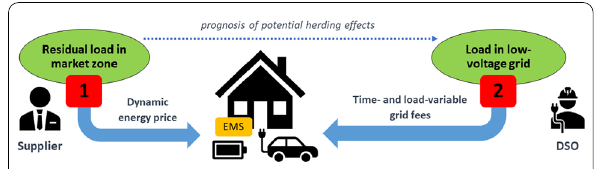
Fig. 1 Concept for communication of market‑ and grid‑oriented price